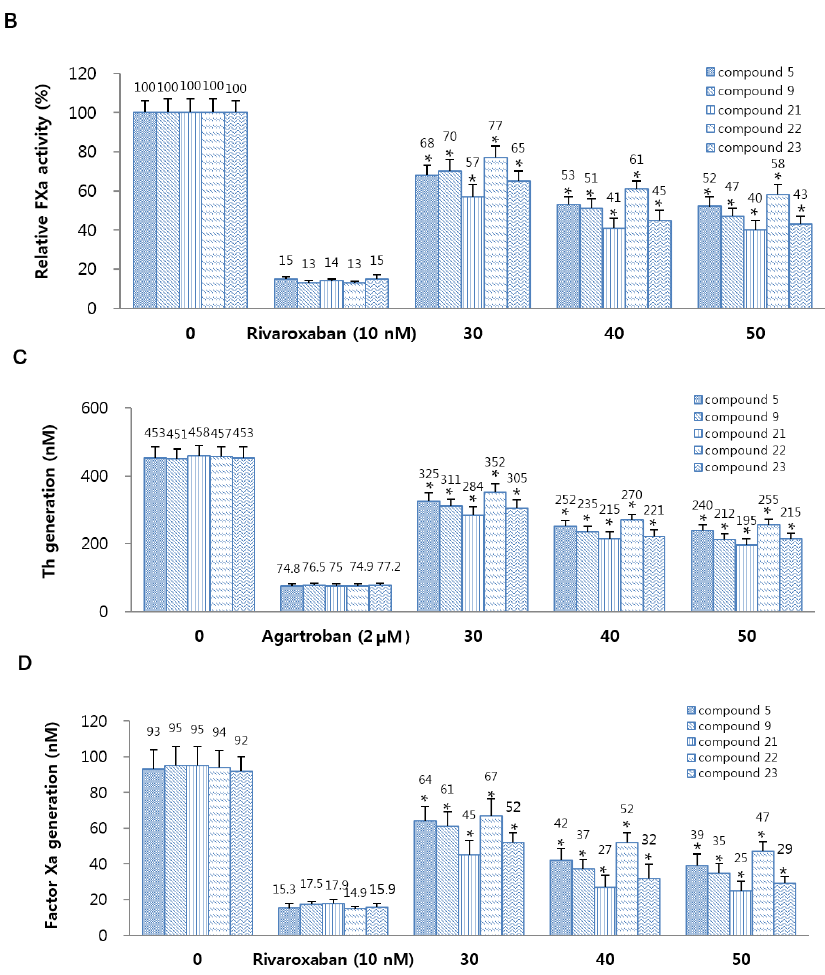
Figure 1. Effects of 5 , 9 , and 21 – 23 on inhibitory activity and generation of thrombin and factor